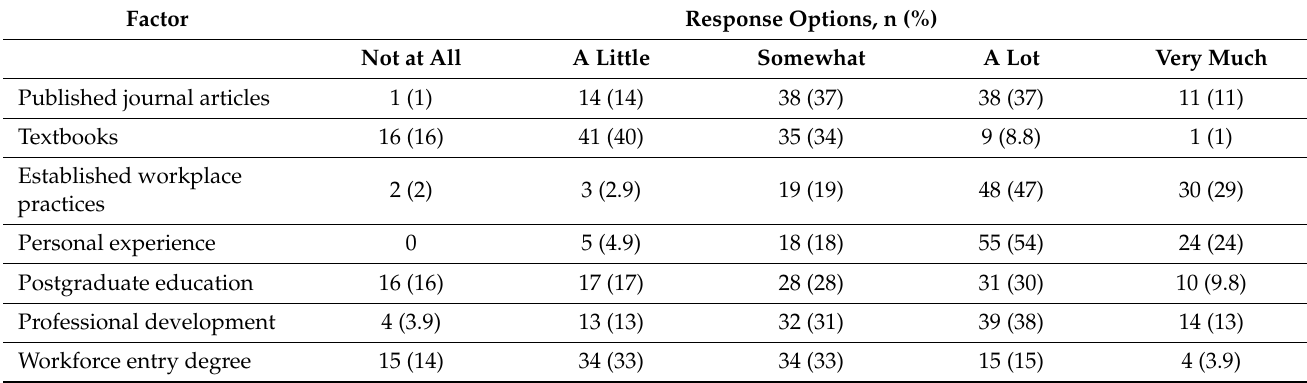
Table 2. Factors influencing respondent management of people with lung